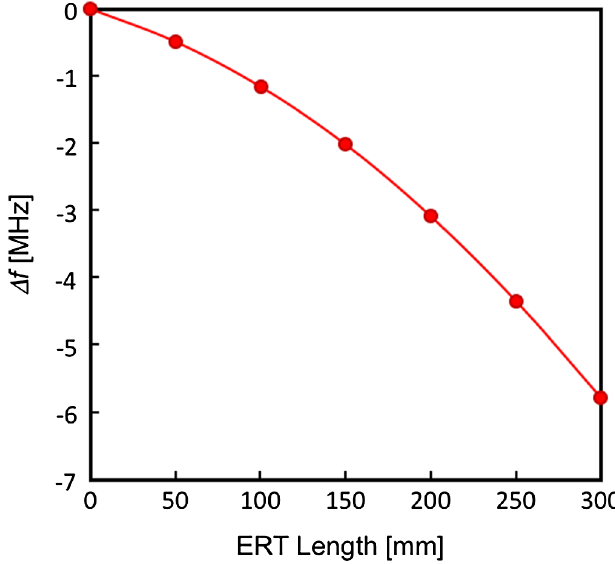
FIG. 3. Frequency shift as a function of the ERT length.